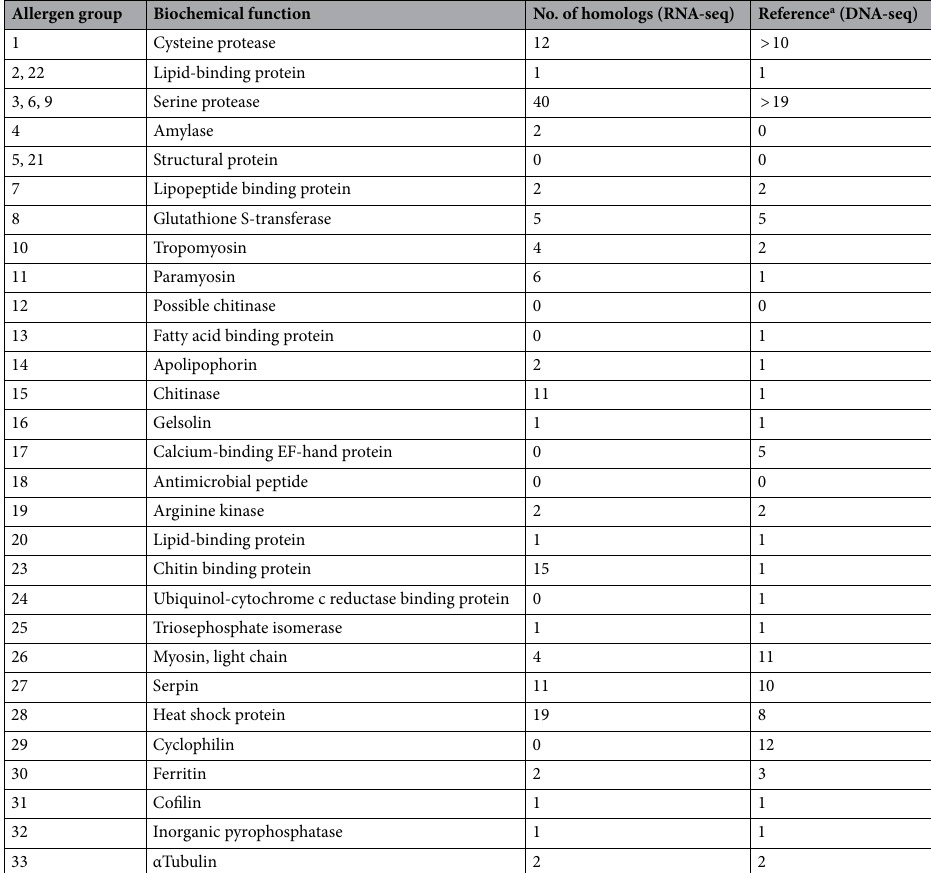
Table 2. Number of predicted house dust mite allergen homologs identified in the Sarcoptes scabiei RNA-seq data. a Rider Jr et al. 16